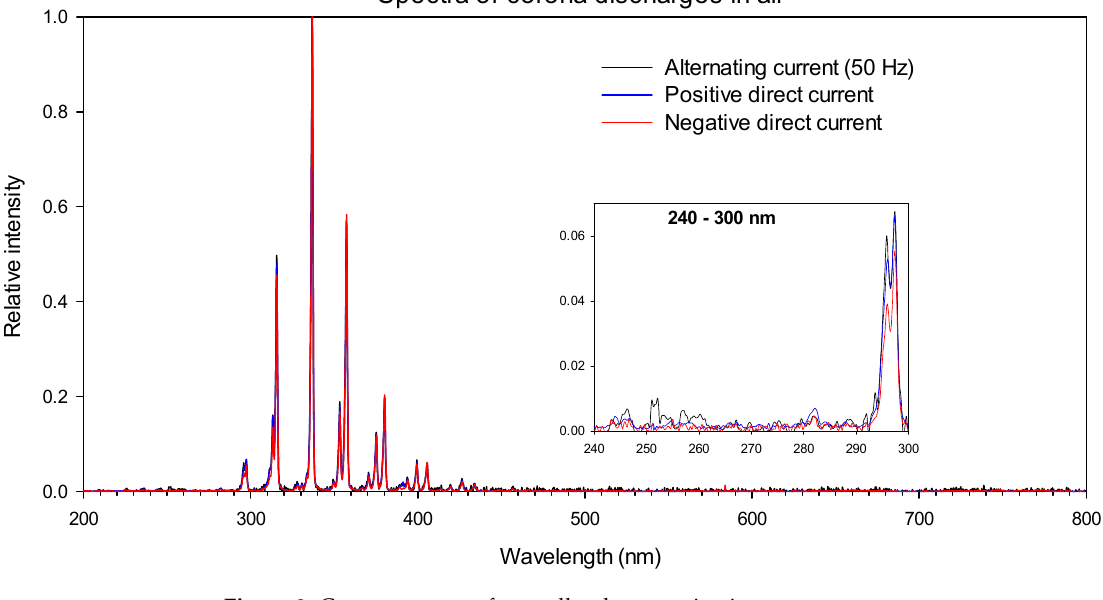
Figure 2. Corona spectra of a needle-plane gap in air.